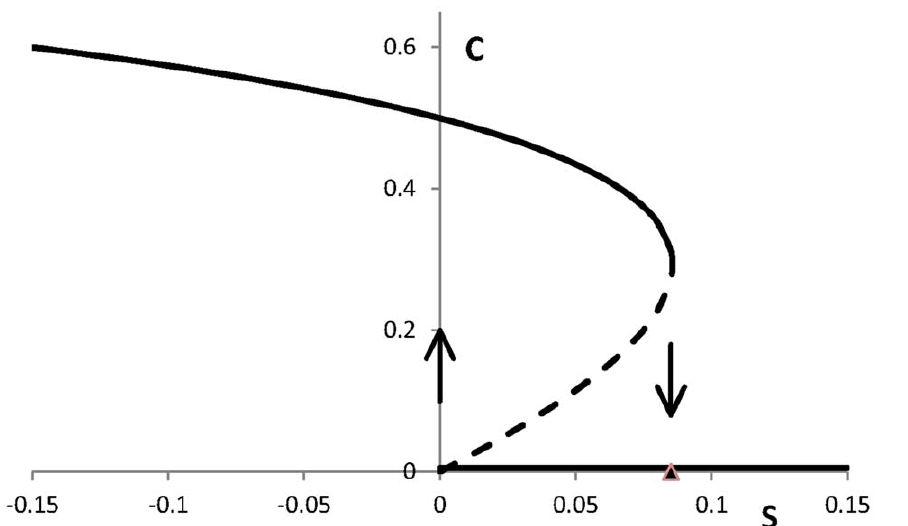
Figure 3. Diagram of the stable (solid) and unstable (dashed) equilibrium states of the system (1ab) as a function of S with the values of the other parameters given in the text. If S varies the system exhibits hysteresis: depending on the history of S the system is in one of the two stable states arising in the interval [0, 0.085].